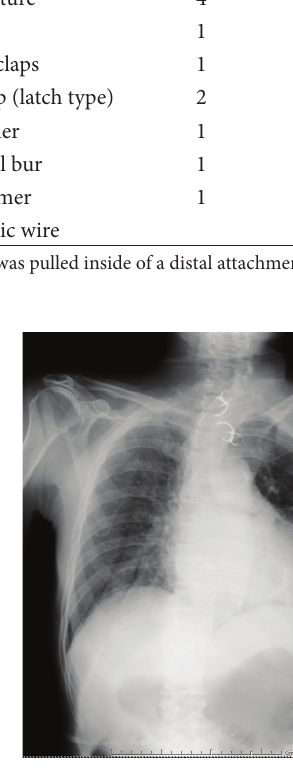
Figure 1: Plain chest radiography showing the ingested partial denture in the cervical